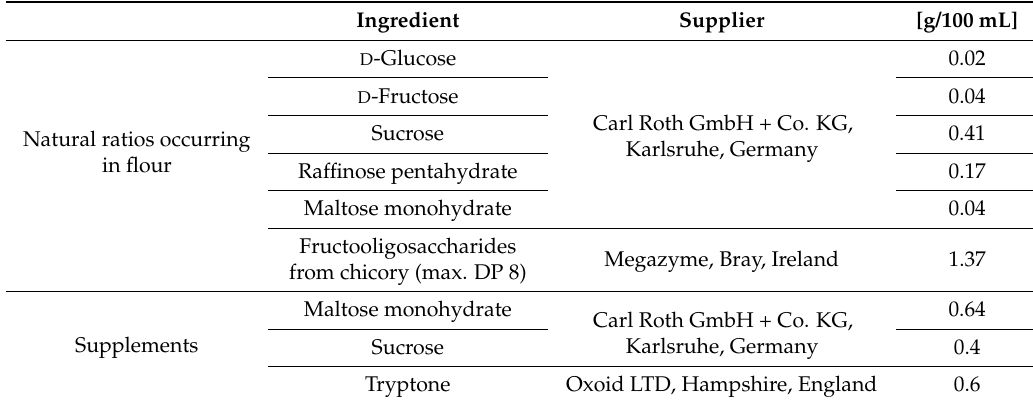
Table 2. Medium composition of the model system